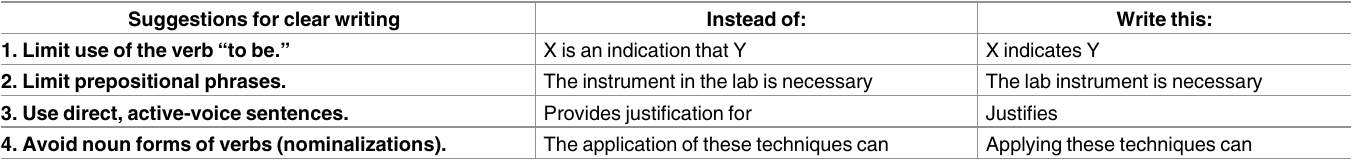
Table 1. Suggestions for how to implement clear writing. Suggestions for clear